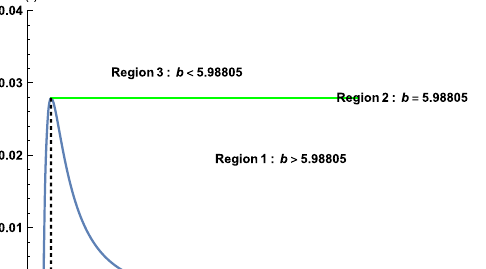
Table 1 The values of radius r ph and impact parameter b ph of the photon sphere, and of the event horizon r h and cosmological horizon r c for various w with M = 1, a = 0 . 05